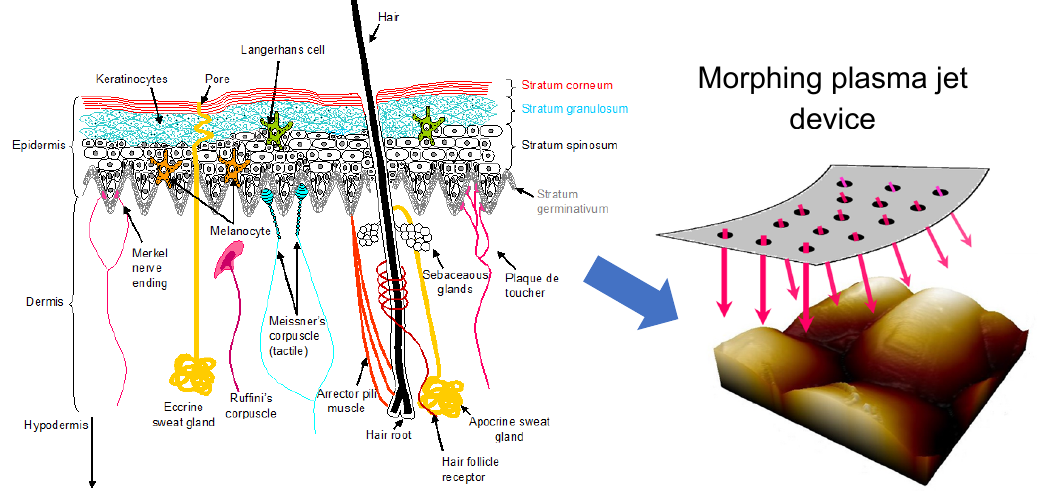
Figure 14. Drawing of skin cross section and schematic representation of a morphing plasma jet source treating a sample with irregular topography. Flexibility, versatility, and efficiency are crucial aspects in the APPJ source performance. In the treatment of skin, the plasma-operating parameters should be tuned considering the penetration depths of plasma species vs. layer thicknesses of epidermis ( ≈ 40 μ m–1 mm), dermis ( ≈ 1 mm), and hypodermis ( ≈ 10 mm).